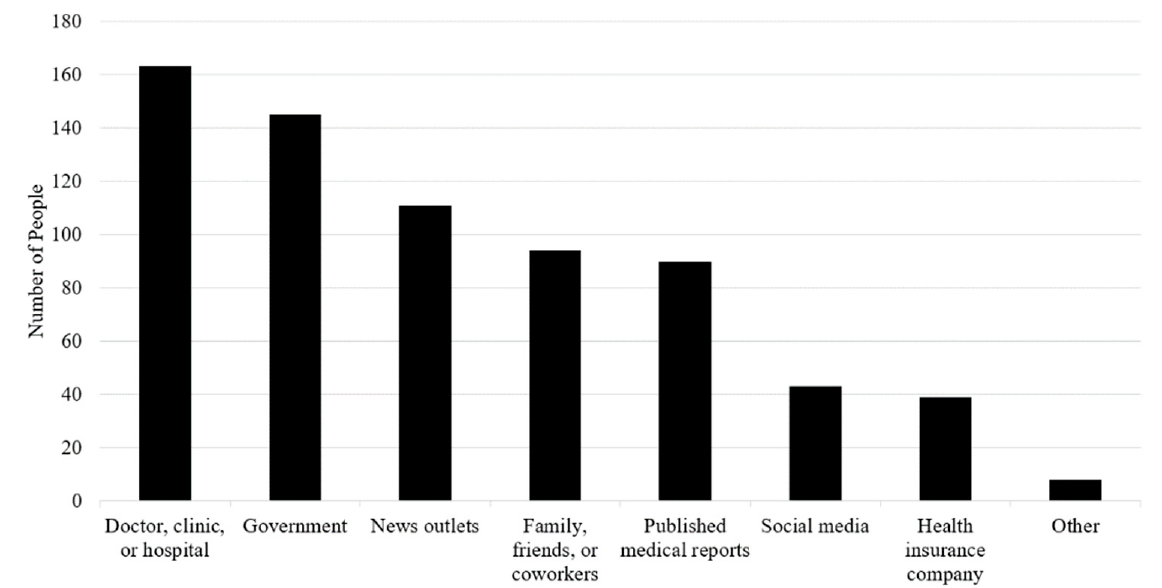
Figure 2. Sources of information about vaccines against coronavirus disease 2019 (COVID-19). Table 2. Characteristics and beliefs associated with the intention to receive a COVID-19 vaccine. LINEAR modeling of 31 demographic and attitude variables in 205 people prior to participating in a